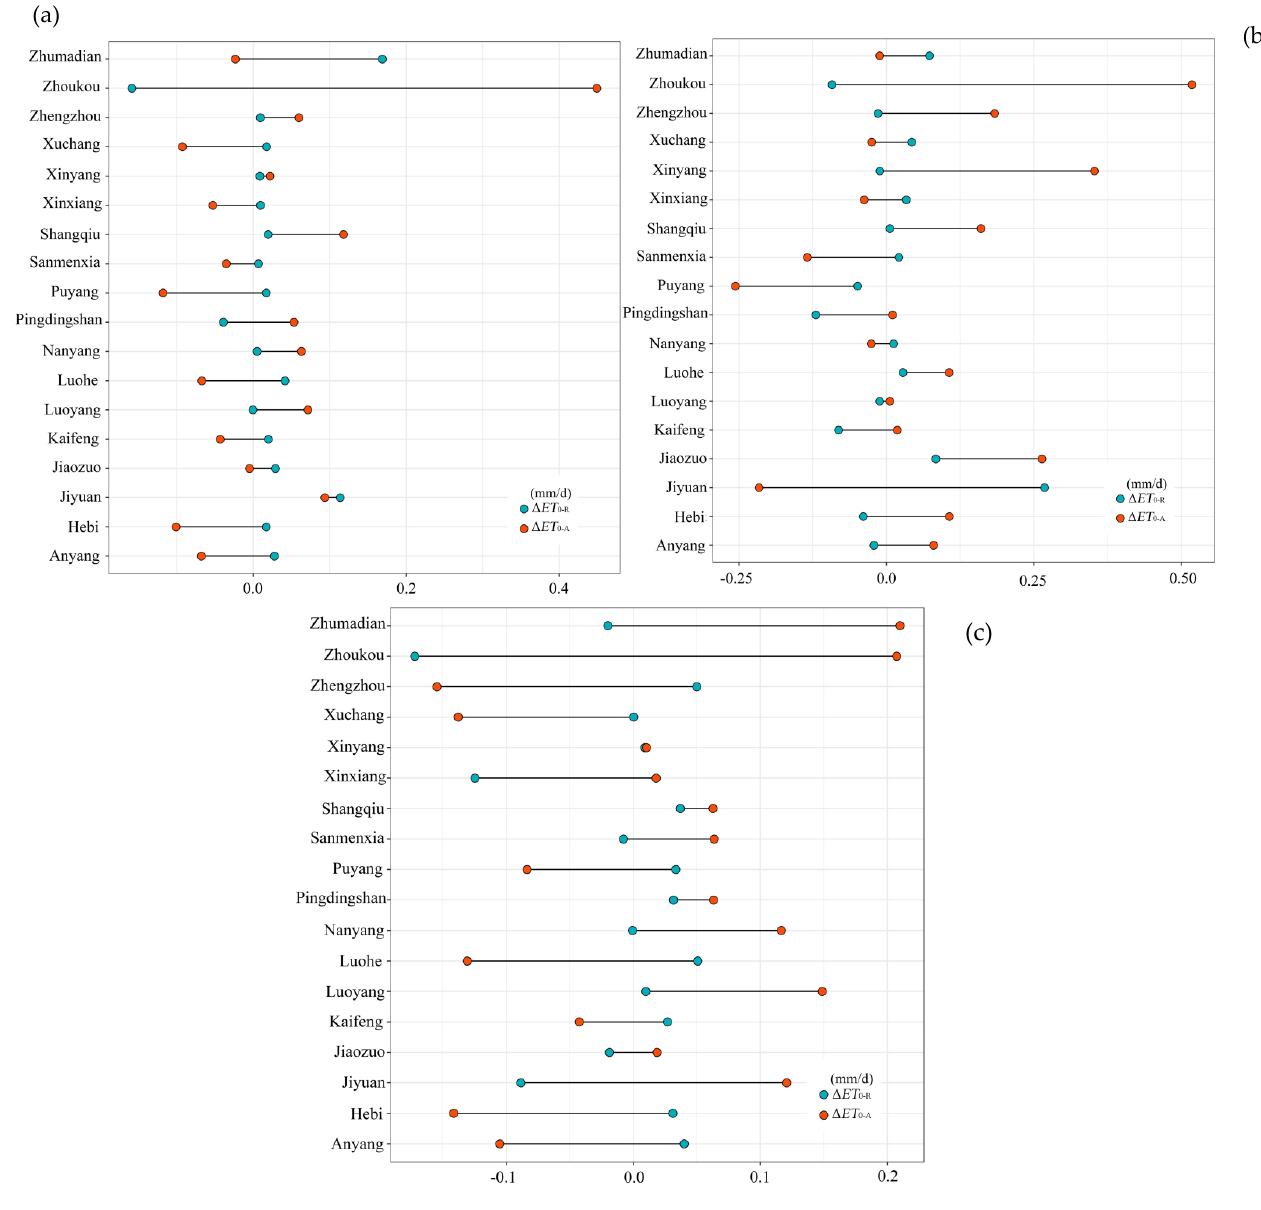
Figure 8. The effect of aerosols on the ET 0 radiation term and aerodynamic term values in each city under the full-time ( a ), pollution ( b ), and good ( c ) conditions.